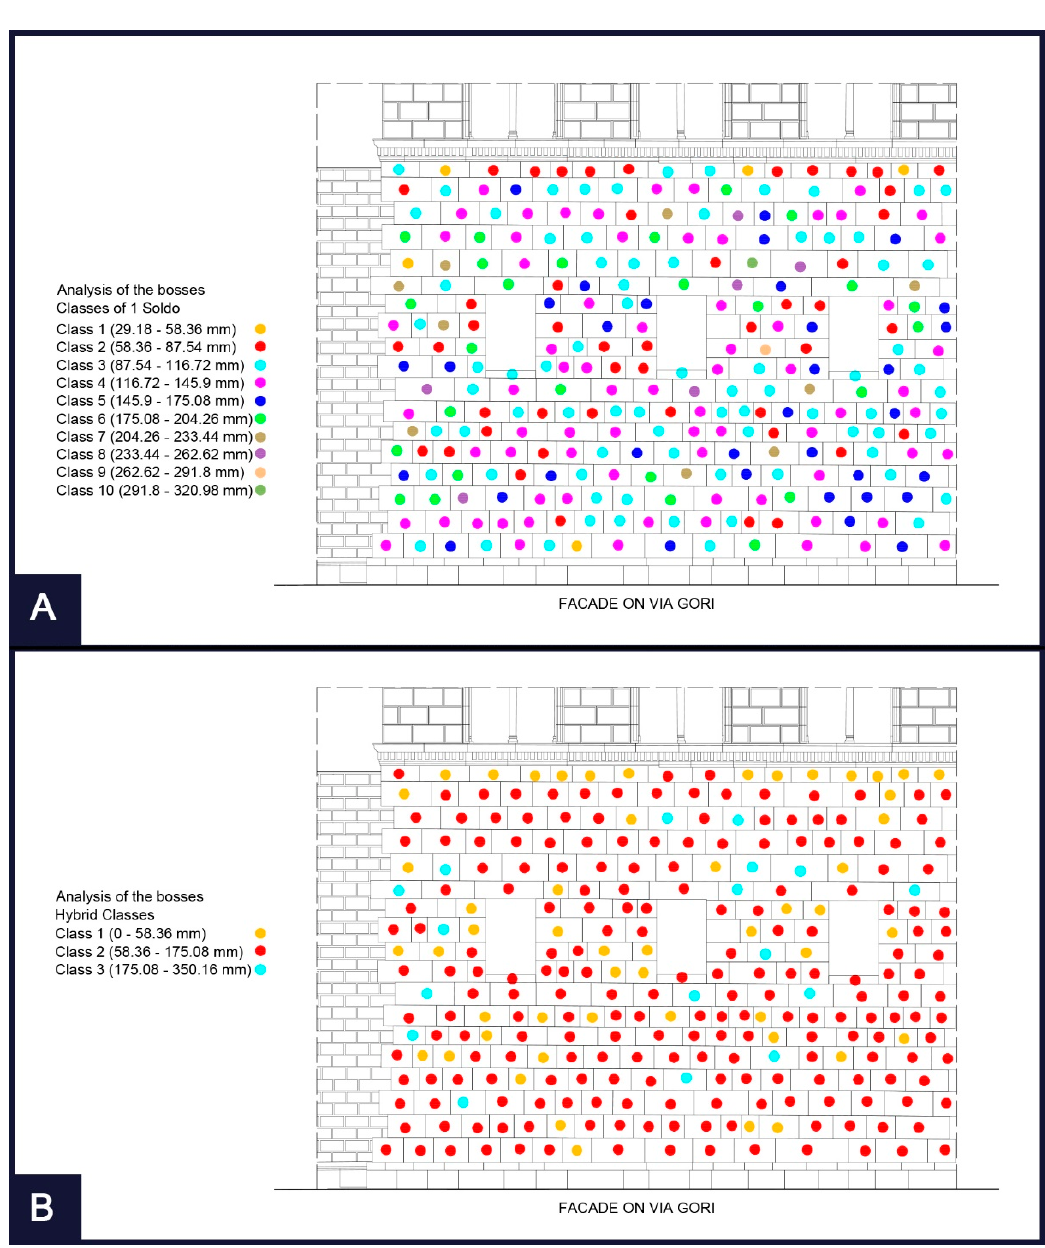
Figure 7. Morphological analysis report of the bosses’ projections and lengths expressed in the unit of measurement of the time: ( A ) the “Soldo” (singular) or “Soldi” (plural) is a submultiple of the “Braccio Fiorentino”; and ( B ) graphic distribution that highlighted a uniform distribution attributable to three macro classes.